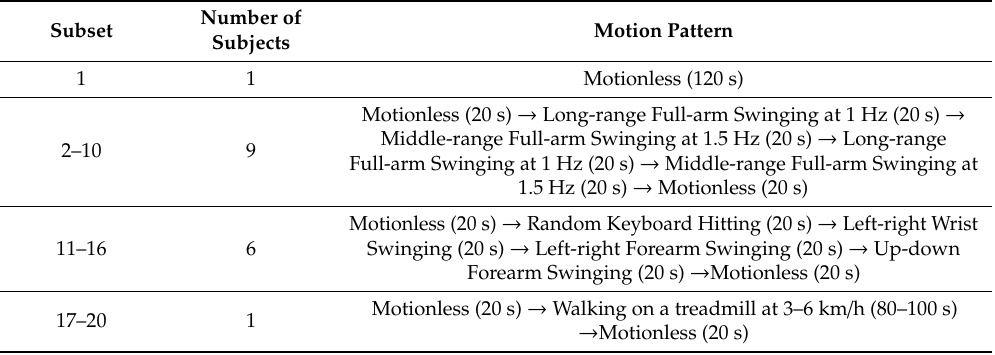
Table 5. Detailed description for the motion patterns of the practical